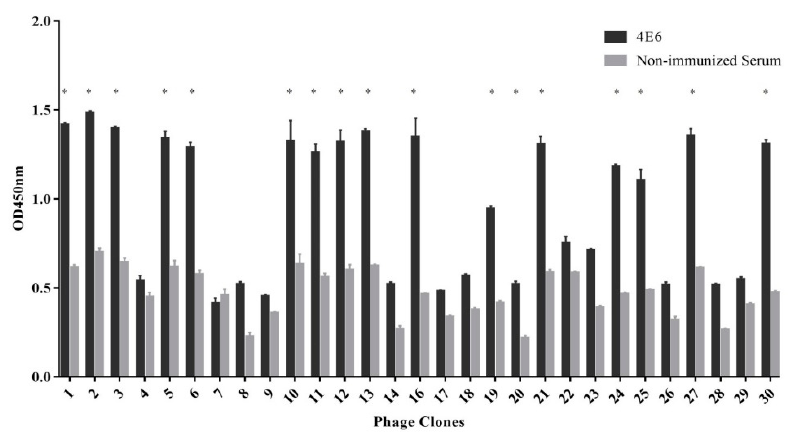
Figure 3. Phage ELISA for the selected phages using mAb 4E6 or non-immunized serum. Three independent assays were performed for each selected phage. *, the phage clones showed specific reactivity with mAb 4E6 (OD 4E6 / OD non-immunized serum > 2.1).